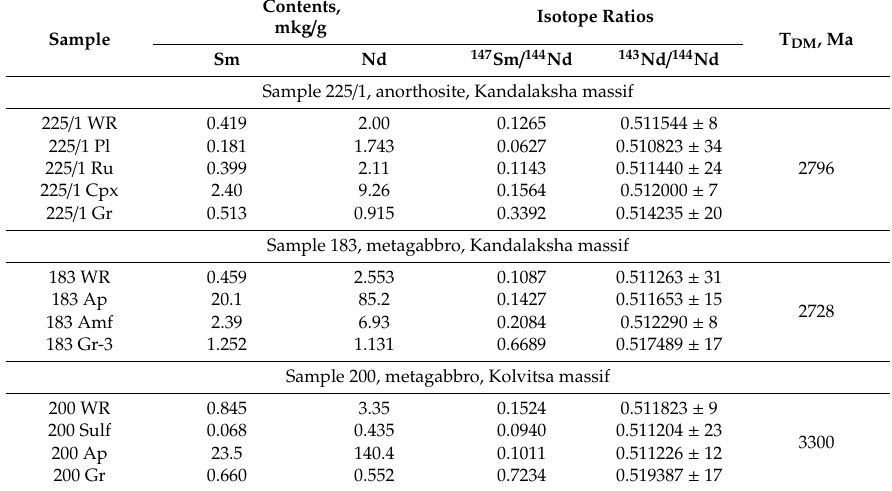
Table 4. Results of the Sm–Nd isotope analysis of rocks and minerals from the Kolvitsa and Kandalaksha gabbro-anorthosite